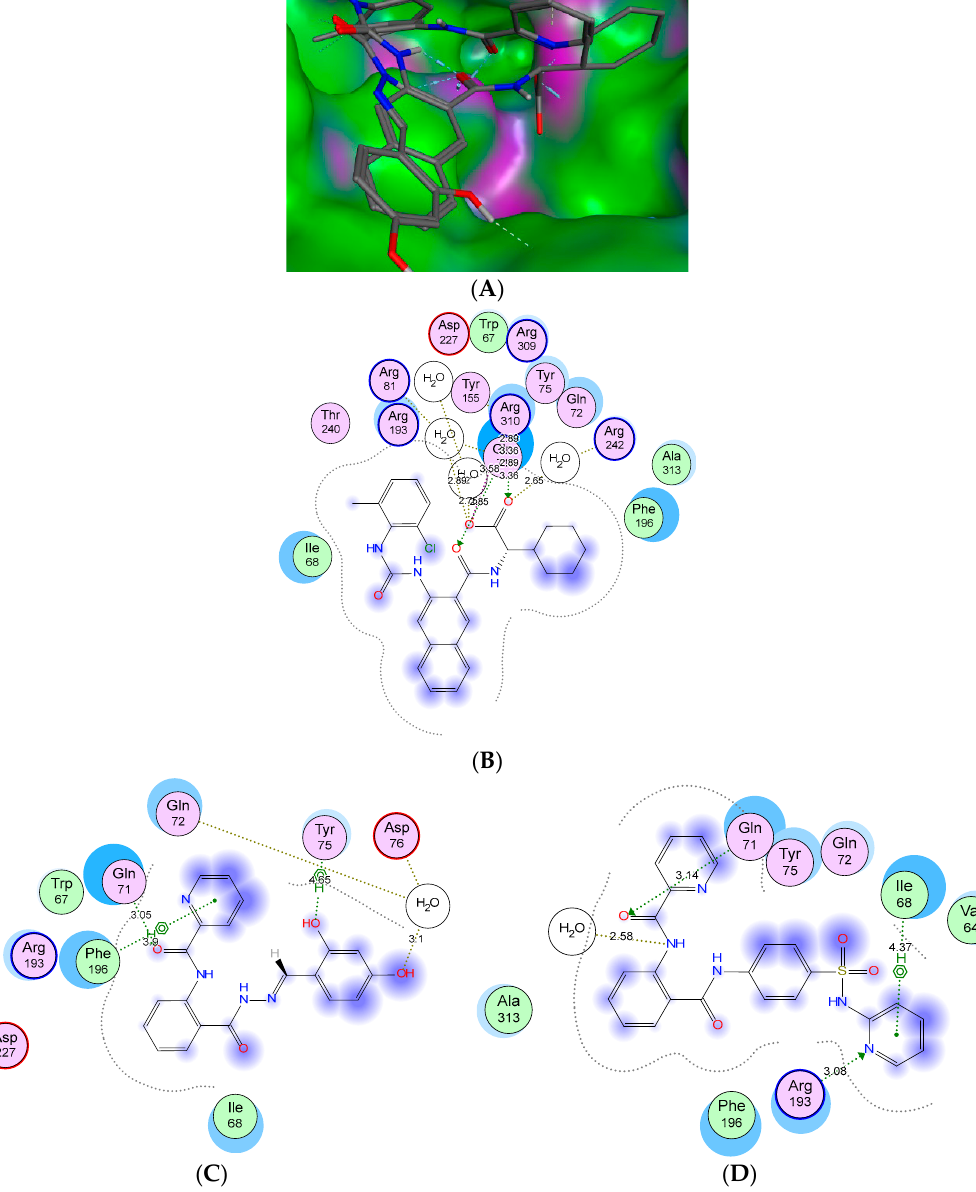
Figure 4. Docking of selected compounds ( 7b ) and ( 5b ) with glycogen phosphorylase protein target, PDB (3DD1). 3D and 2D interaction graphs are reported for ( A ) 3D target structure; ( B ) bound drug; GSK254, ( C ) ( 7b ) and ( D ) ( 5b ).